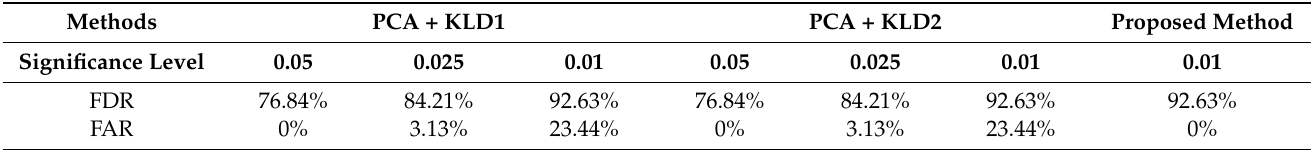
Table 2. Comparison of the performance of three different methods at detecting the spread-spectrum transponder fault.